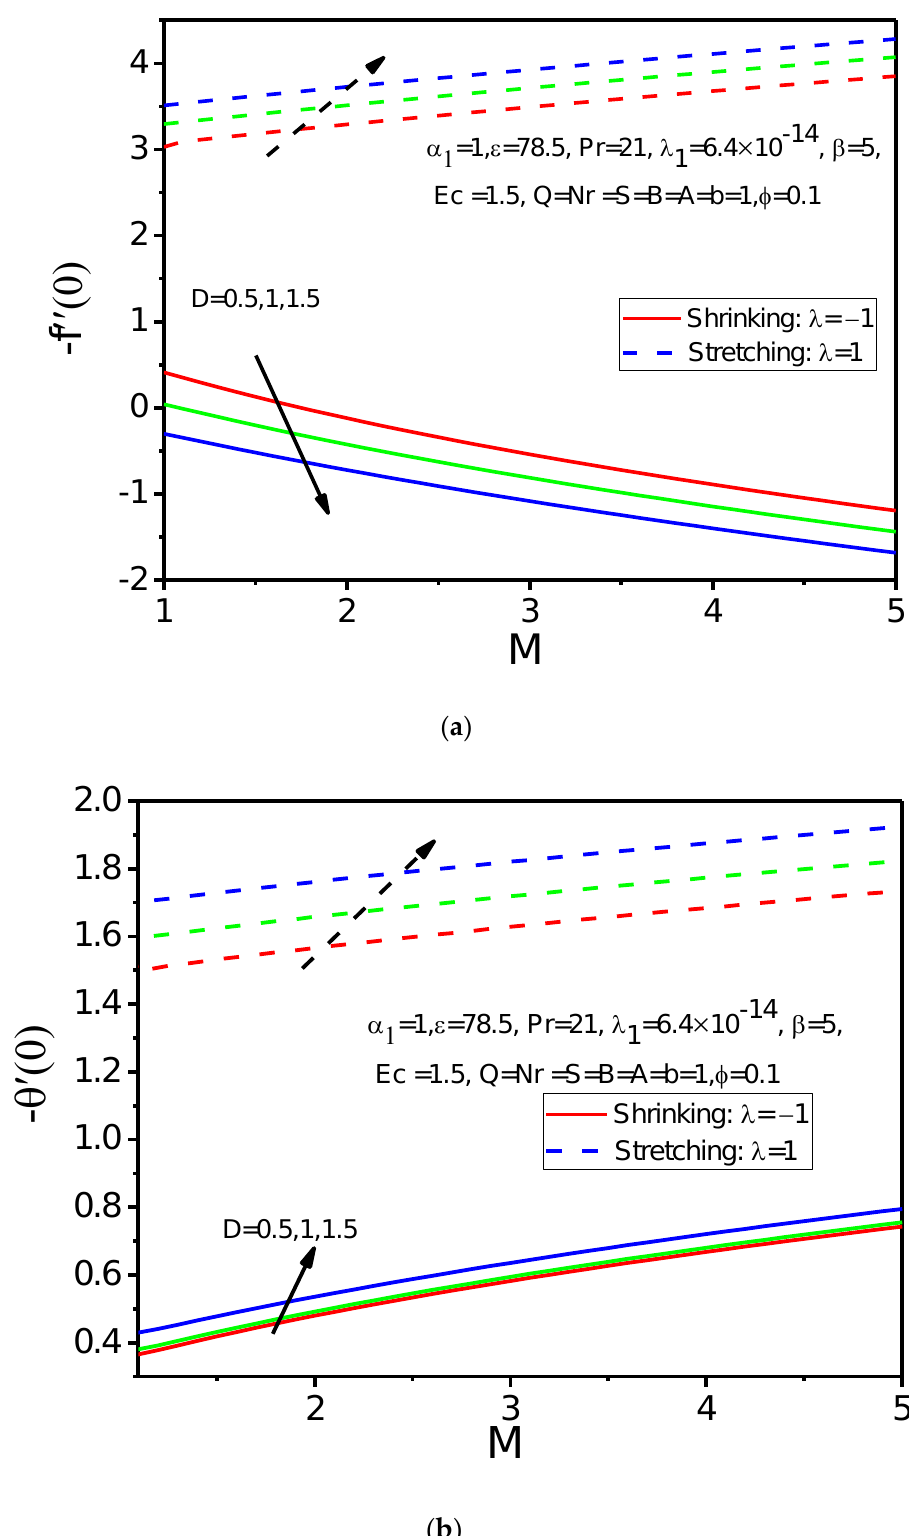
D M against on ( a ) Skin friction coefficient, ( b ) Rate of heat transfer. Figure 14. Influence of D against M on ( a ) Skin friction coefficient, ( b ) Rate of heat